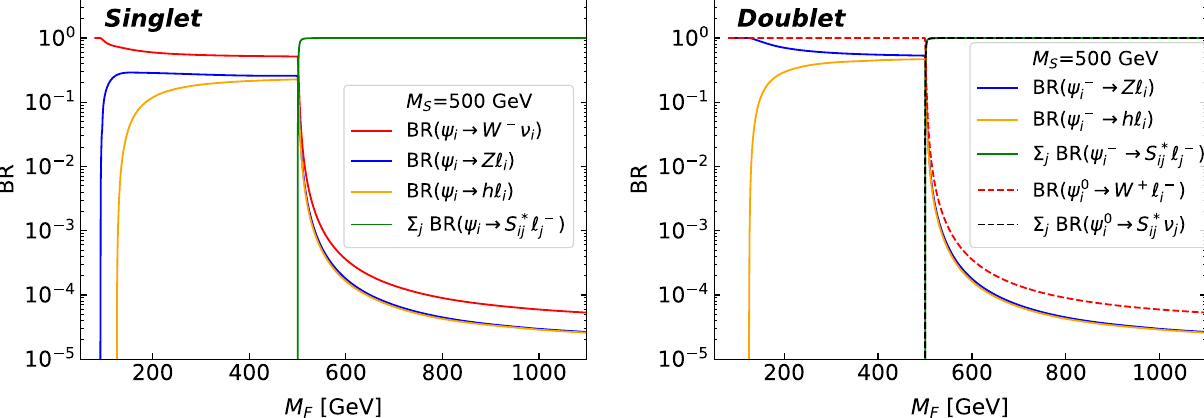
Fig. 3 Branching ratios of the on-shell decays of the VLLs as a function of their mass in the singlet model (left) and the doublet model (right) for M S = 500 GeV and (7). Larger ratios κ/κ (cid:4) would enhance the branching ratios of the electroweak